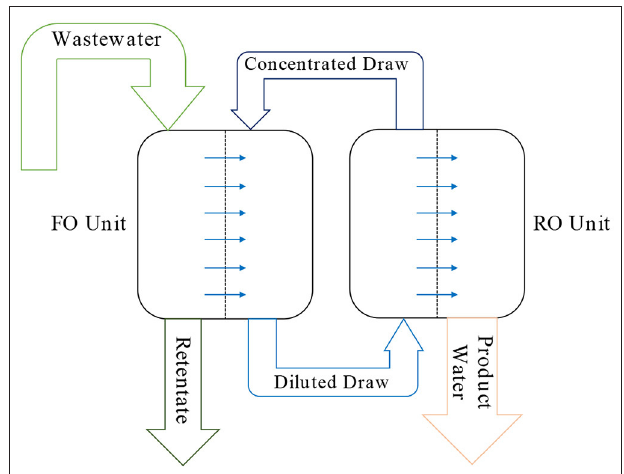
FIGURE 2 | Schematic diagram of the FO-RO hybrid wastewater treatment system.